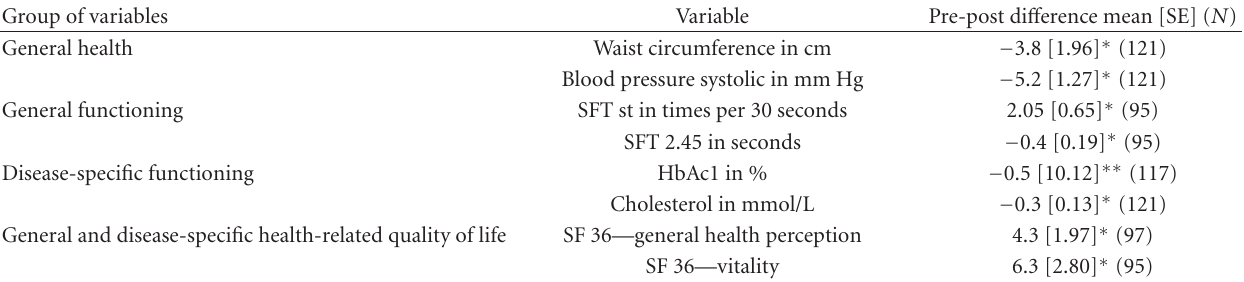
Table 3: Statistically significant e ff ects of the merged lifestyle